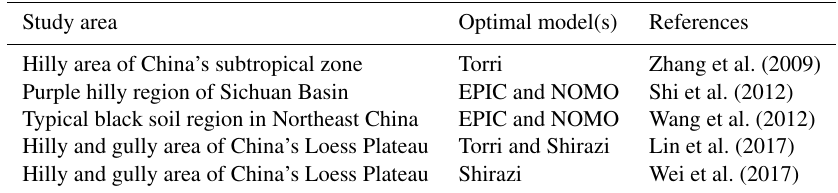
Table 4. Suggested soil erodibility estimation models in